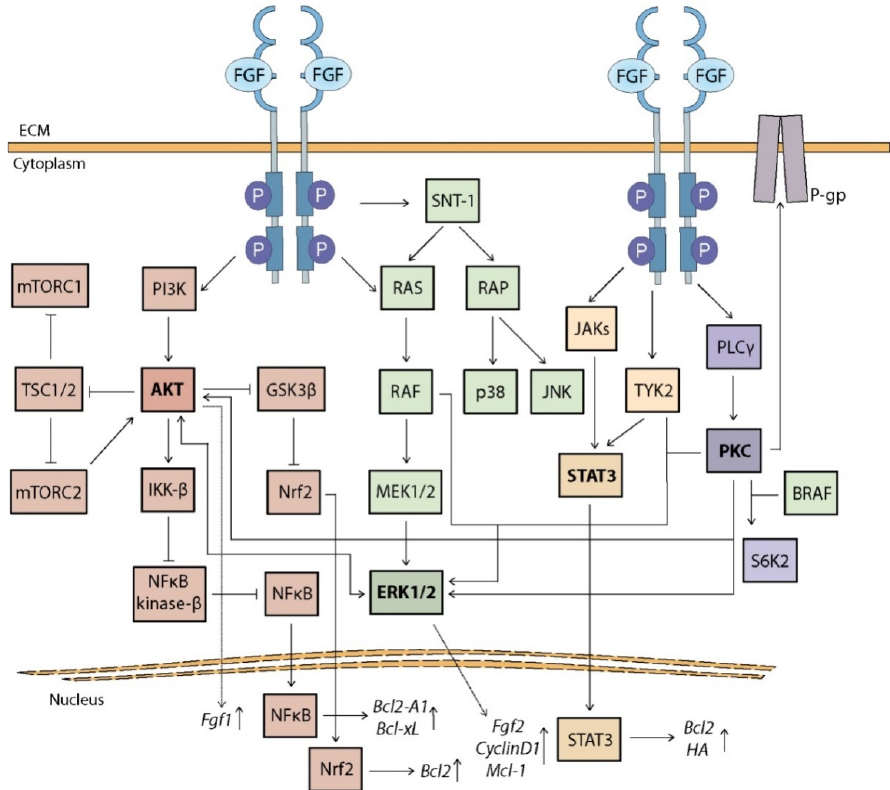
Figure 2. FGFR ‐ dependent cell signaling in the development of drug resistance . Many drugs show reduced efficacy over time. Recent studies have linked this phenomenon to activation of FGFR and disruption of its downstream signaling including mutations of individual signaling proteins, im ‐ paired signal transduction and cross ‐ talks between different cascades. The mode of action of PI3K/AKT in the development of chemoresistance is mainly based on the upregulation of pro- survival genes such as Bcl2-A1 or Bcl-xL by activation of IKK β or inactivation of GSK3 β and further nuclear translocation of NF κ B or Nrf2, respectively. Another mechanism is inhibition of TSC1/2 affecting protein synthesis. Activation of ERK kinases in MAPK pathway appears to be crucial in the acquisition of drug resistance, as it leads to increased expression of proteins associated with cell cycle progression (e.g., cyclin D1) and apoptosis control (e.g., Mcl-1). Another signaling pathway